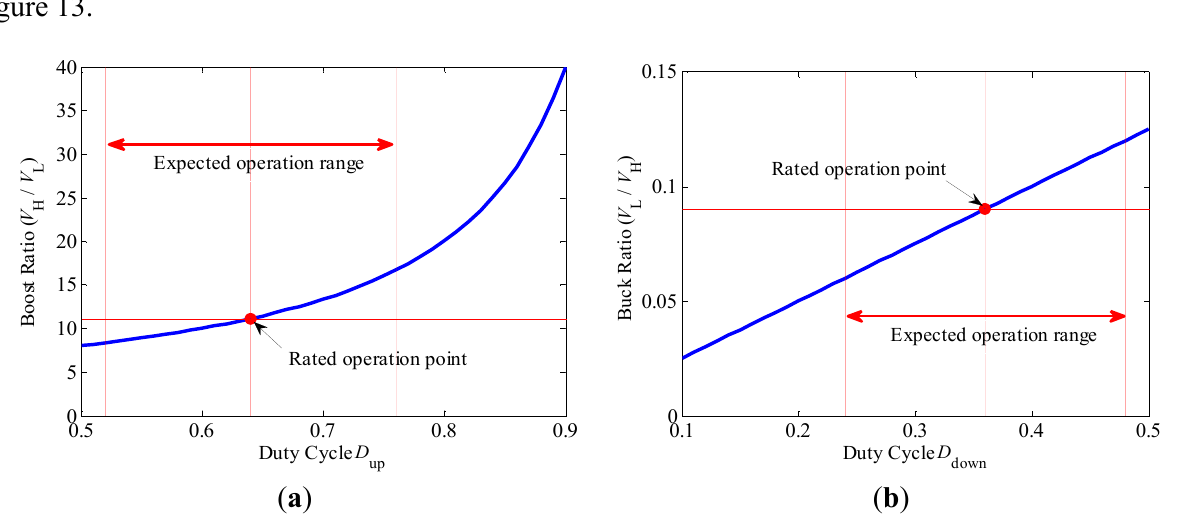
Figure 13. Duty cycles versus voltage gain ( a ) CCM Boost operation; ( b ) CCM Buck